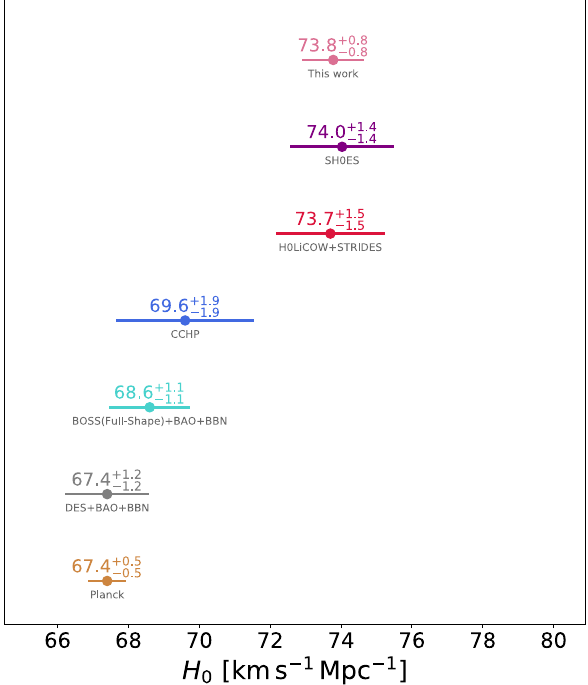
Fig. 3 Compilation of H 0 measurements taken from recent literature, namely, from Planck collaboration (Planck) [12], Dark Energy Sur- vey Year 1 Results (DES+BAO+BBN) [118], the final data release of the BOSS data (BOSS Full-Shape+BAO+BBN) [117], The Carnegie- Chicago Hubble Program (CCHP) [16], H0LiCOW collaboration (H0LiCOW+STRIDES) [14], SH0ES [13], in comparison with the H 0 constraints obtained in this work from the GP analysis using SN+BAO+CC+H0LiCOW